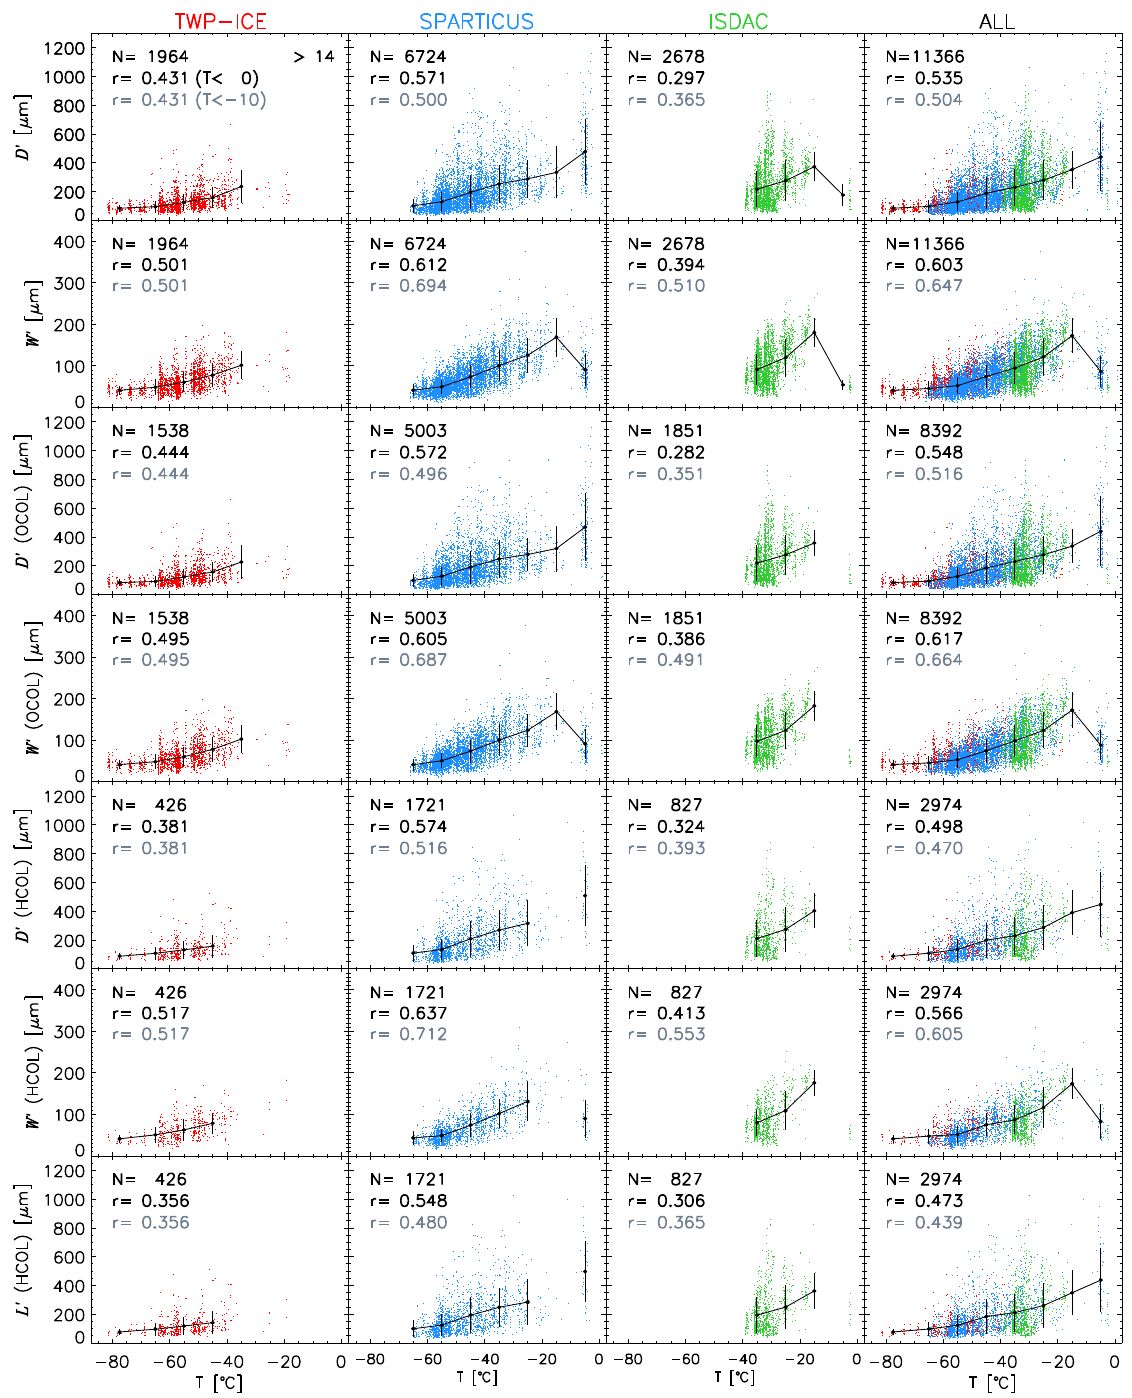
Figure 5. Measured D (cid:48) , W (cid:48) , and L (cid:48) of columns as a function of temperature. From left, data from TWP-ICE, SPARTICUS, ISDAC, and all three field campaigns combined (ALL) are shown in each column. HCOL and OCOL indicate columns with horizontal orientation and columns with other orientations, respectively. The number of pristine crystals analyzed is embedded in each panel. The mean and standard deviation are indicated with black circles and vertical bars in each panel calculated over each 10 ◦ C temperature interval from 0 ◦ C, except for − 85 < T < − 70 ◦ C. Correlation coefficients ( r ) for − 85 < T < 0 ◦ C (black) and for − 85 < T < − 10 ◦ C (gray) are embedded in each